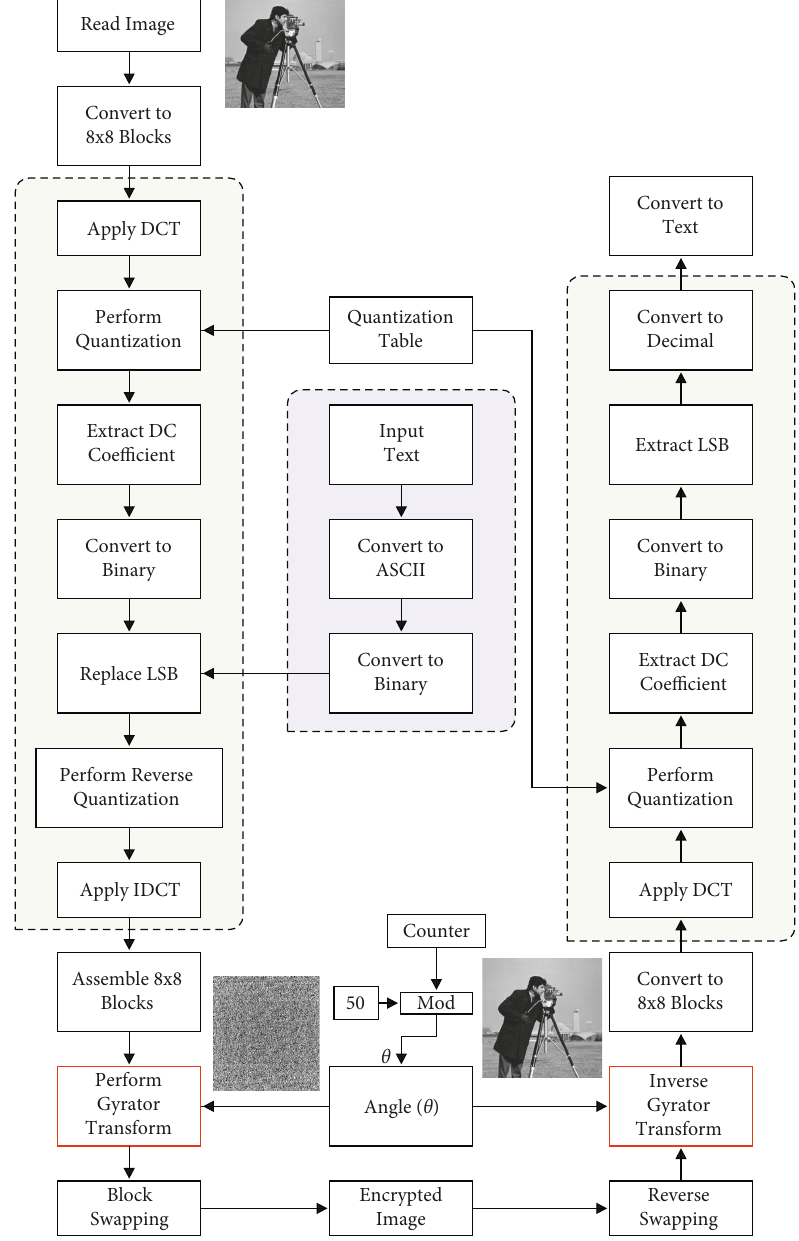
Figure 1: Block diagram of the proposed